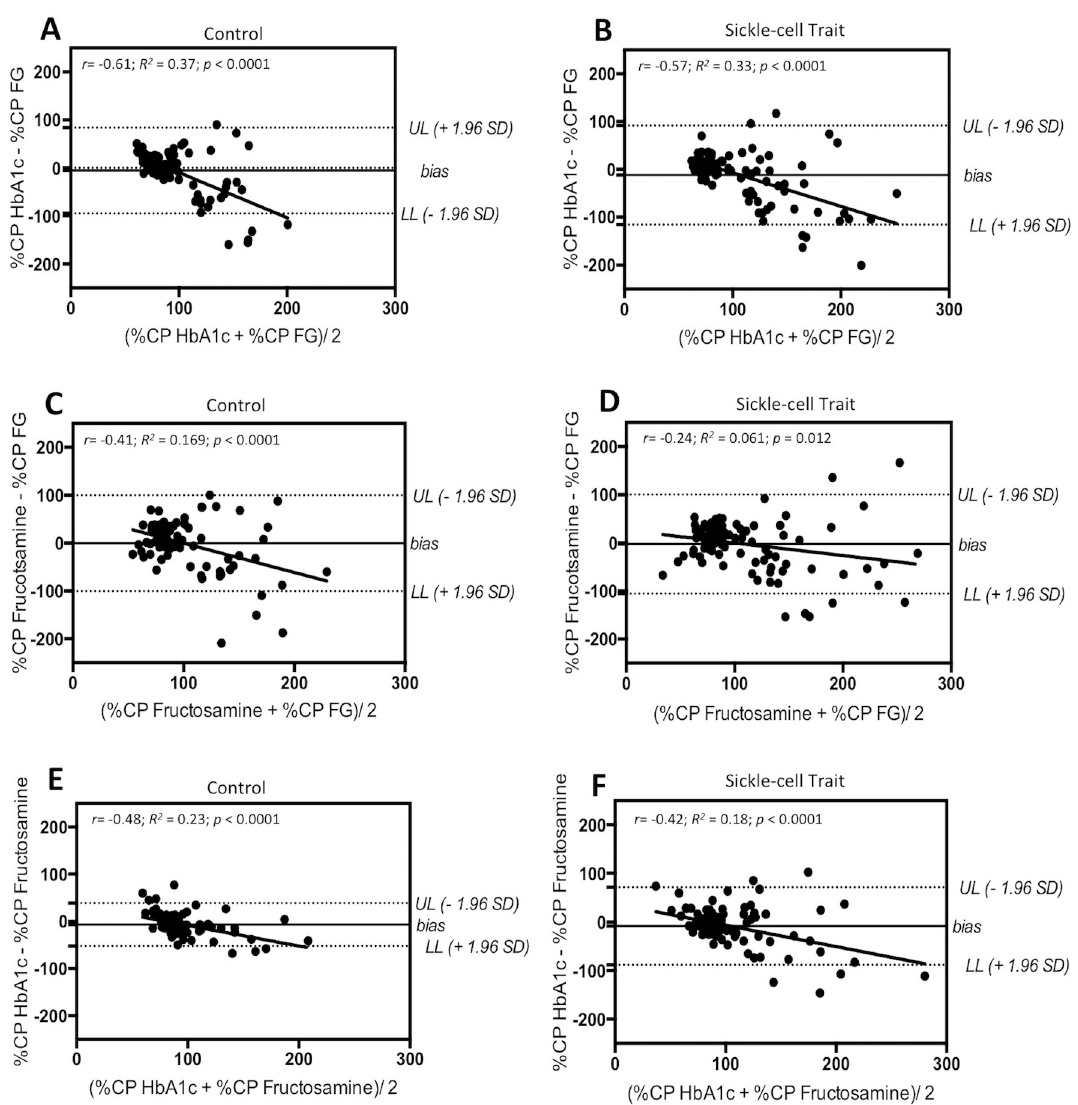
Fig 2. Bland-Altman plots showing the agreement between glycated hemoglobin A1c (HbA1c) and fasting glucose (FG) (plots A and B), fructosamine and FG (plots C and D), and HbA1c and fructosamine (plots E and F) for the control (plots A, C, and E) and sickle-cell trait groups (plots B, D, F). Each plot represents the mean of the two methods (x-axis) against their differences. The mean difference between the two methods (bias) is shown, as are the Upper (UL) and Lower limits (LL) of agreement. %CP HbA1c = percent of the clinical cut-point of HbA1c. %CP FG = percent of the clinical cut-point of fasting glucose. %CP Fructosamine = percent of the clinical cut-point of